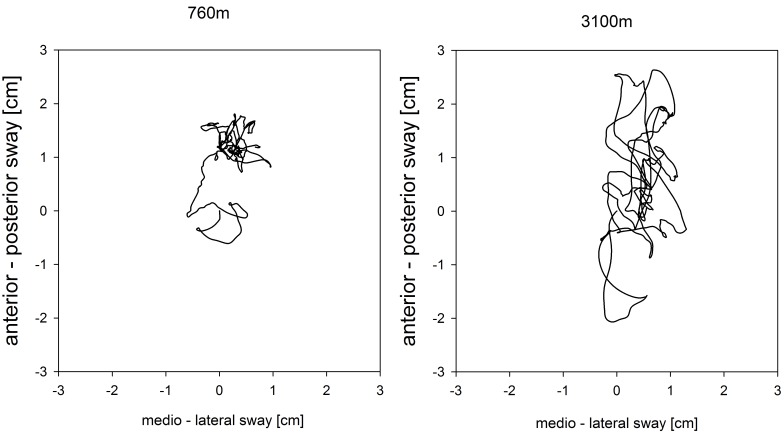
Example of a center of pressure path in an individual COPD patient at 760 m (left) and at 3100 m (right). Measurement at 760 m and 3100 m: center of pressure path length (COPL), 21.6 and 39.8 cm; antero-posterior sway velocity, 0.476 and 0.995 cm/s; medio-lateral sway velocity, 0.437 and 0.67 cm/s.